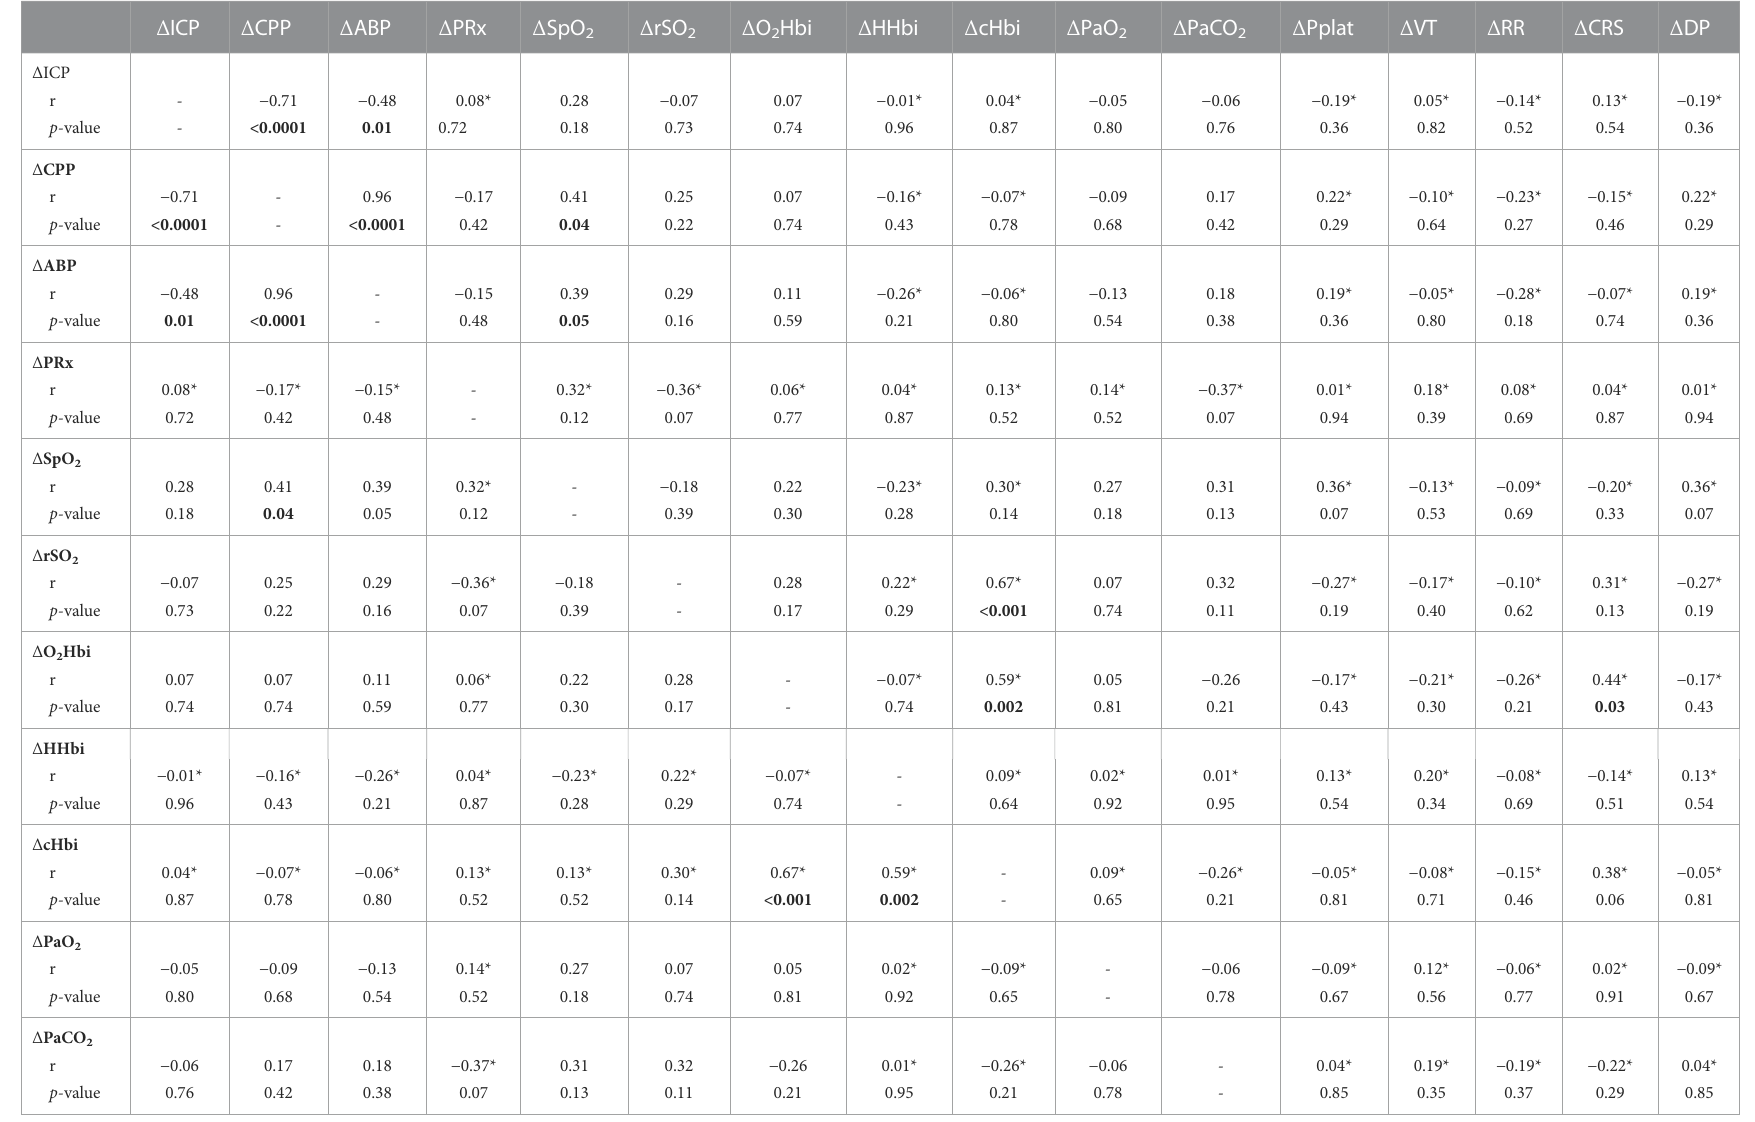
r: correlation coef fi cient. * represents Spearman correlation coef fi cients; the remaining values represent Pearson correlation coef fi cients. ICP:intracranialpressure; CPP:cerebralperfusionpressure; PRx:pressurereactivityindex;rSO 2 :regionaltissueoxygensaturation; Δ O 2 Hbi:indexrepresentingthechangeintheoxyhemoglobinoftheregional tissue oxygensaturation; Δ HHbi:indexrepresentingthe change in the deoxyhemoglobin of the regional tissue oxygen saturation; Δ HHbi: index representing the change in total hemoglobin; SpO 2 : systemic oxygen saturation; PaO 2 : partial pressure of O 2 . Statistically signi fi cant values are presented in